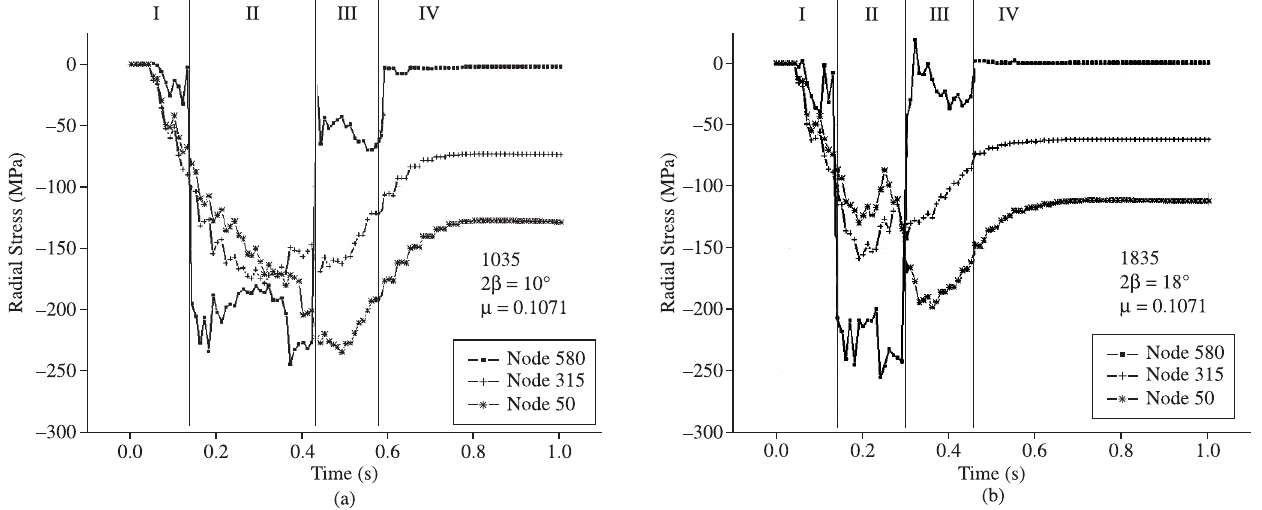
Figure 4. Radial Stress behavior during the wiredrawing process for a) 2 β = 10° and b) 2 β =